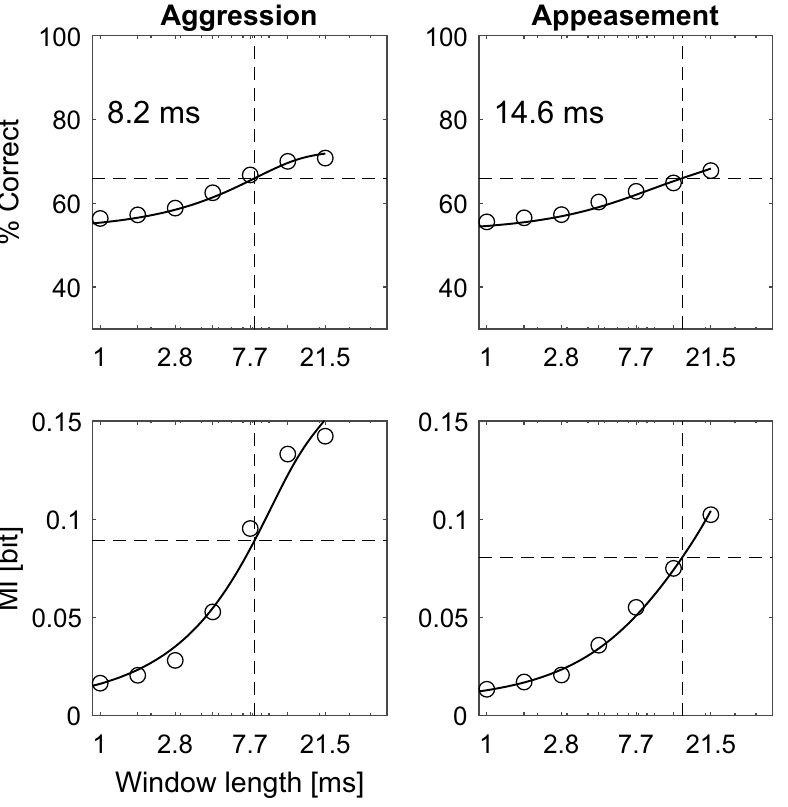
Figure 3. Simulated discrimination performance of the auditory periphery. Top row: Simulated psychometric functions reveal that aggression calls (left) can be discriminated at a shorter phase-randomization window- length than appeasement calls (right). Vertical dashed lines mark the discrimination thresholds of 8.2 and 14.6 ms, respectively. Horizontal dashed lines at 66% correct depict significance level (binomial test, 50 trials, p < 0.01). Bottom row: With increasing phase-randomization window-length, the change in Mutual Information (MI) content is greater for aggression calls (left) than for appeasement calls (right). Horizontal dashed lines mark the MI content of the calls at respective threshold window-lengths (vertical dashed